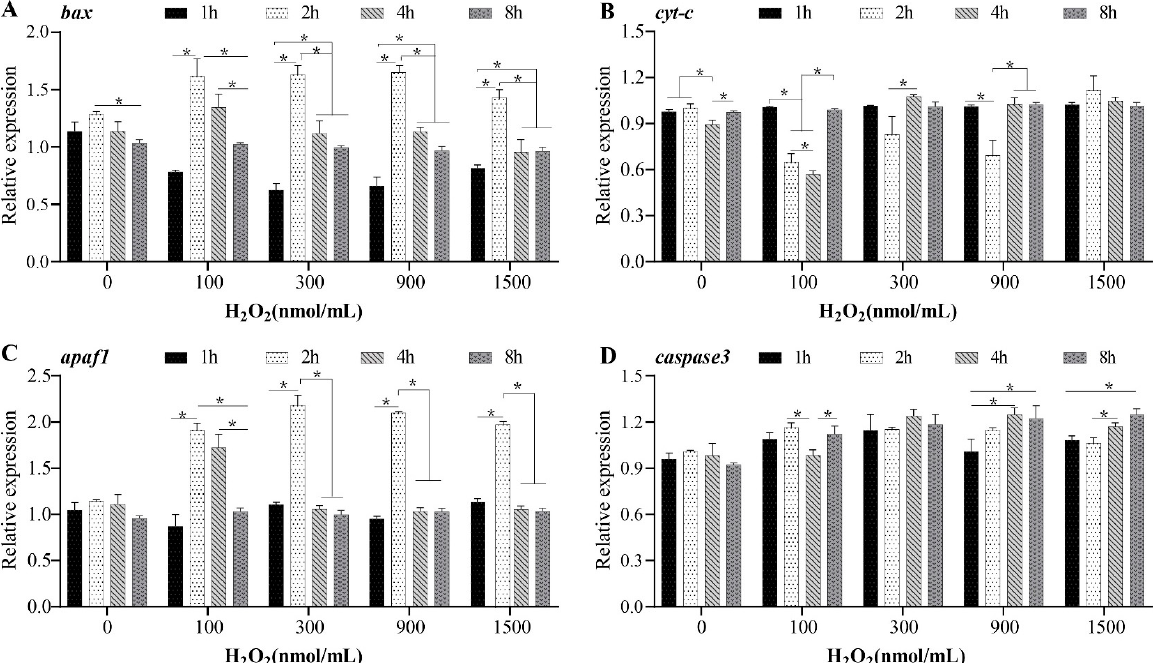
Figure 5 . Expression patterns of mitochondrial pathway-related genes in Monopterus albus ovaries treated with H 2 O 2 in vitro . A, Bax expression patterns in ovaries after incubation with H 2 O 2 ; B, Cyt- c expression patterns in ovaries after incubation with H 2 O 2 ; C, Apaf-1 expression patterns in ovaries after incubation with H 2 O 2 ; D, Caspase3 expression patterns in ovaries after incubation with H 2 O 2 . ( B ), Cyt-c expression patterns in ovaries after incubation with H 2 O 2 ; ( C ), Apaf-1 expression patterns Means marked with different letters are significantly different ( p < 0.05). in ovaries after incubation with H 2 O 2 ; ( D ), Caspase3 expression patterns in ovaries after incubation with H 2 O 2 . Asterisks (*) indicate significant differences between two groups ( p <